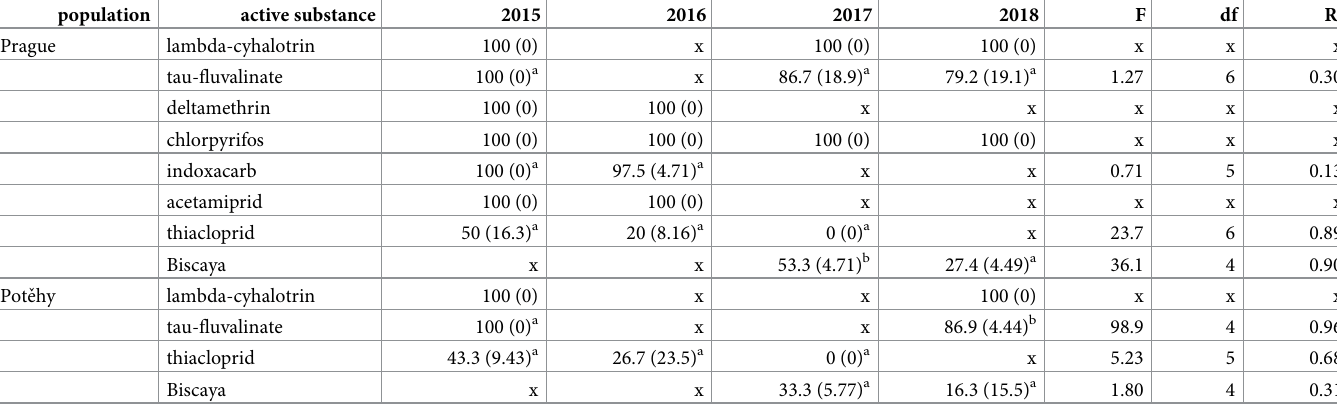
Table 4. Mean mortality (%) of CSFB from Prague and Poteˇhy localities at 100% of the recommended field rate of insecticides. Standard deviations are given in brackets. Values with different letters within a row are significantly different. x–no data available. F, df, R 2 –ANOVA data.